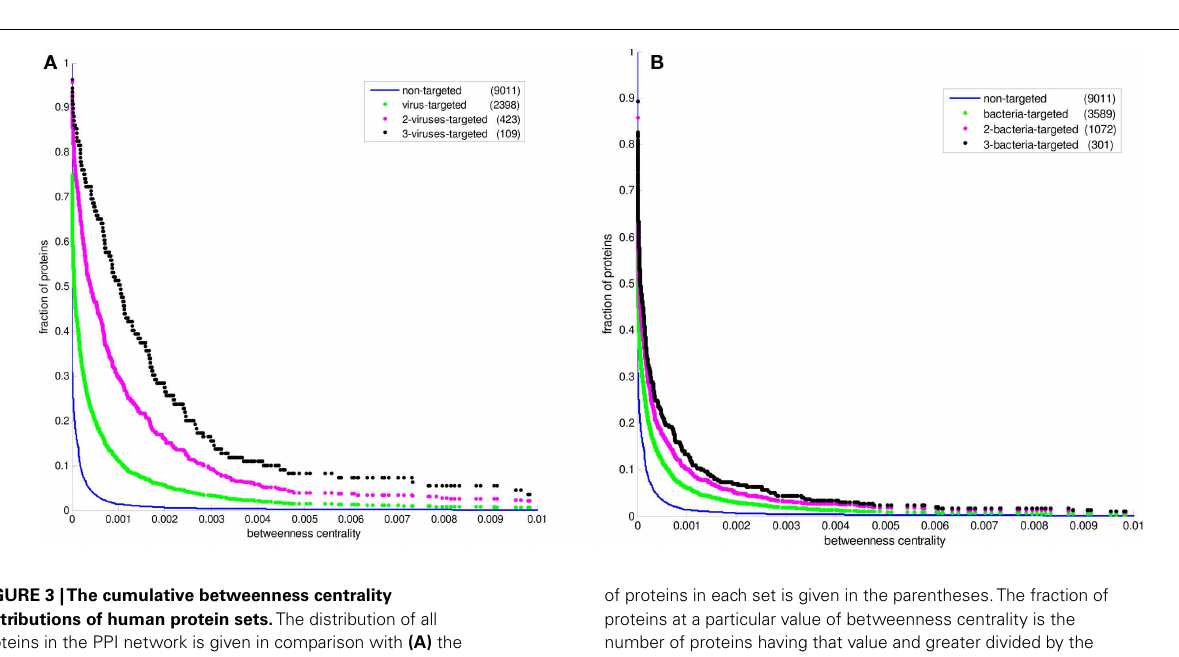
of proteins in each set is given in the parentheses.The fraction of proteins at a particular value of betweenness centrality is the number of proteins having that value and greater divided by the number of proteins in the